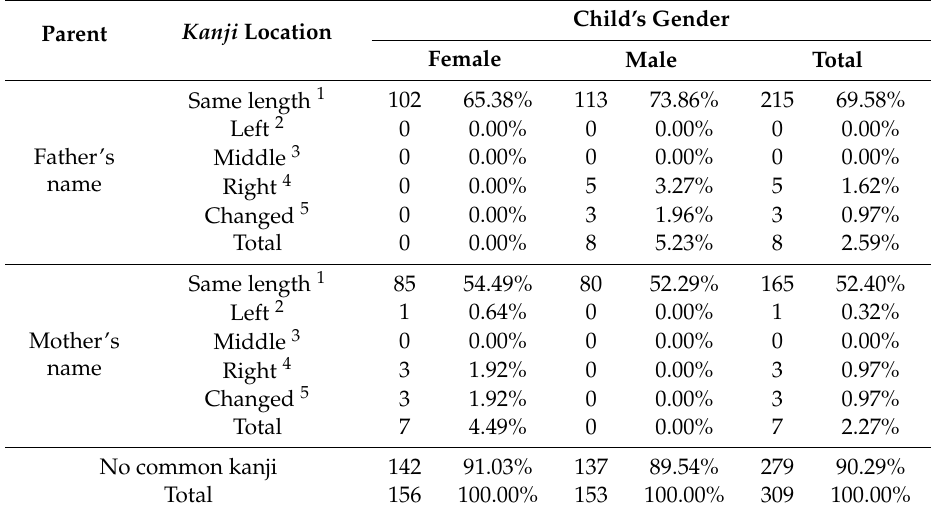
Table 4. Number of paired names with commonalities between parents and children.